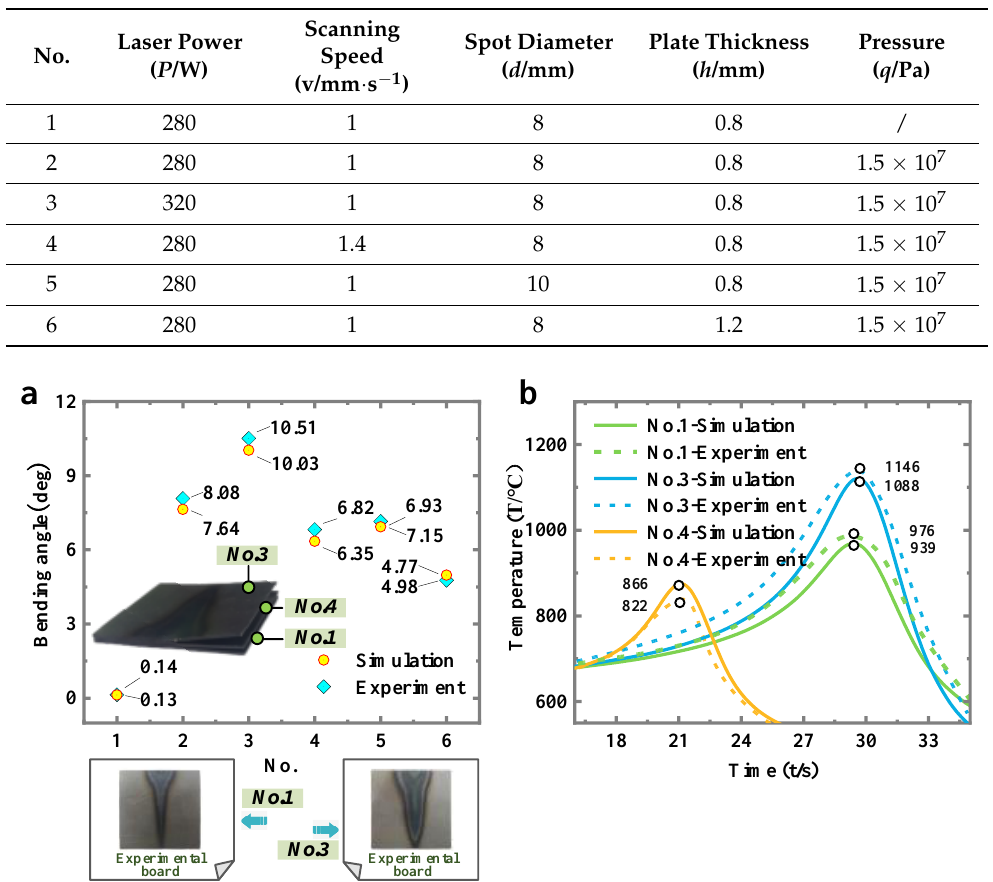
Figure 6. Comparison of results and the processed plate: ( a ) bending angle and ( b ) temperature peak.